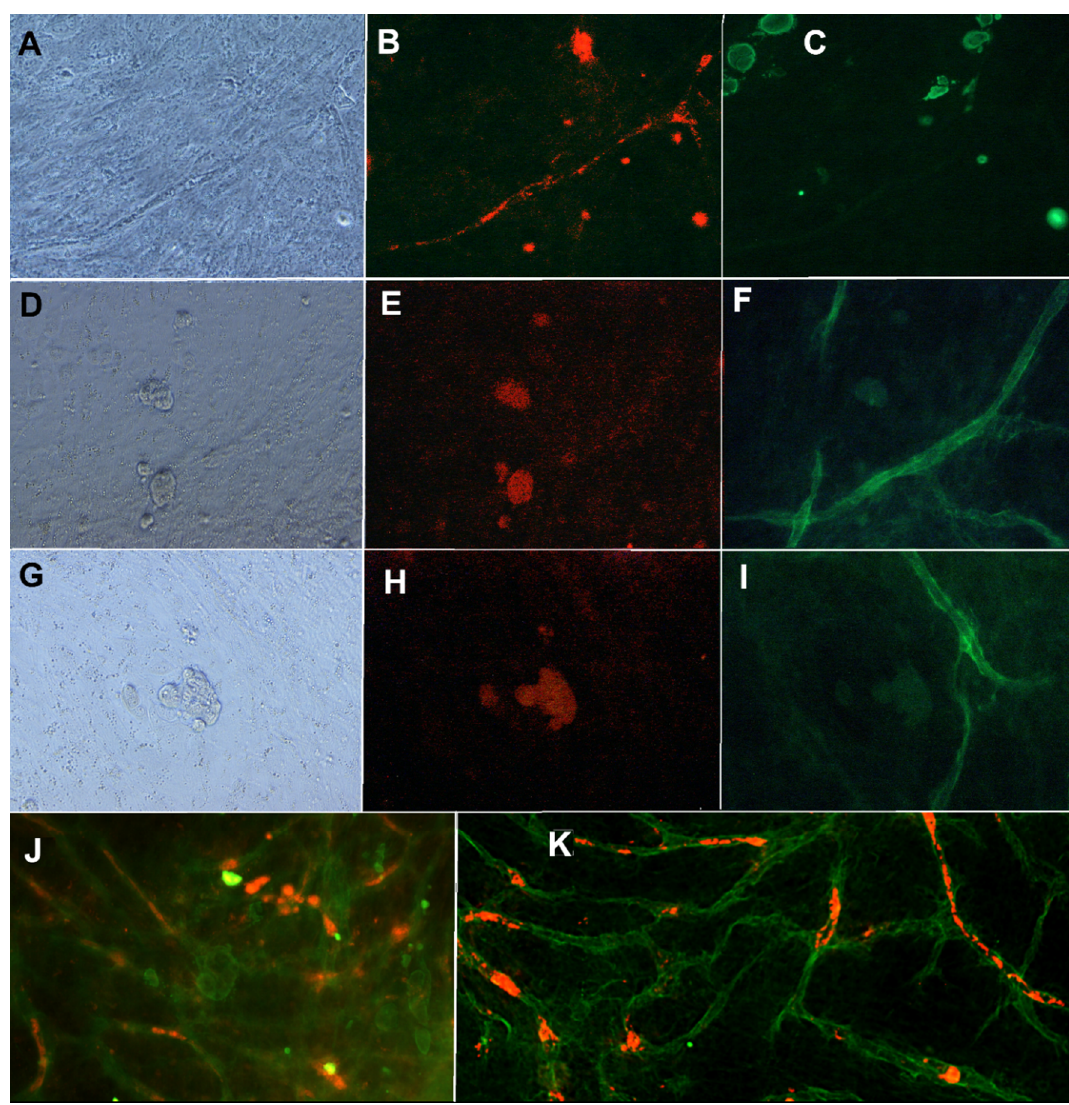
Figure 2. MCF7 cells grown in co-culture with vasculature. First row: ( A ) Phase contrast image, ( B ) anti-VWF (A568, red), and ( C ) anti-CK19 (FITC, green) staining. Second row: ( D ) Phase contrast image, ( E ) anti-CD44 (TRICH, red), and ( F ) anti-collagen IV (FITC, green) staining. Third row ( G ) Phase contrast image, ( H ) anti-ALDH1A1 (TRICH, red), and ( I ) anti-collagen IV (FITC, green). Images obtained with Nikon Eclipse Ti-s inverted fluorescence microscope with 20x objective. ( J ): MCF7 cells in co-culture with vasculature stained with anti-CK19 (FITC, green) and anti-VWF (A568, red). ( K ) same co-cultured stained with anti-collagen IV (FITC, green) and anti-ALDH1A1 (red). Imaged with Zeiss cell discoverer 7.